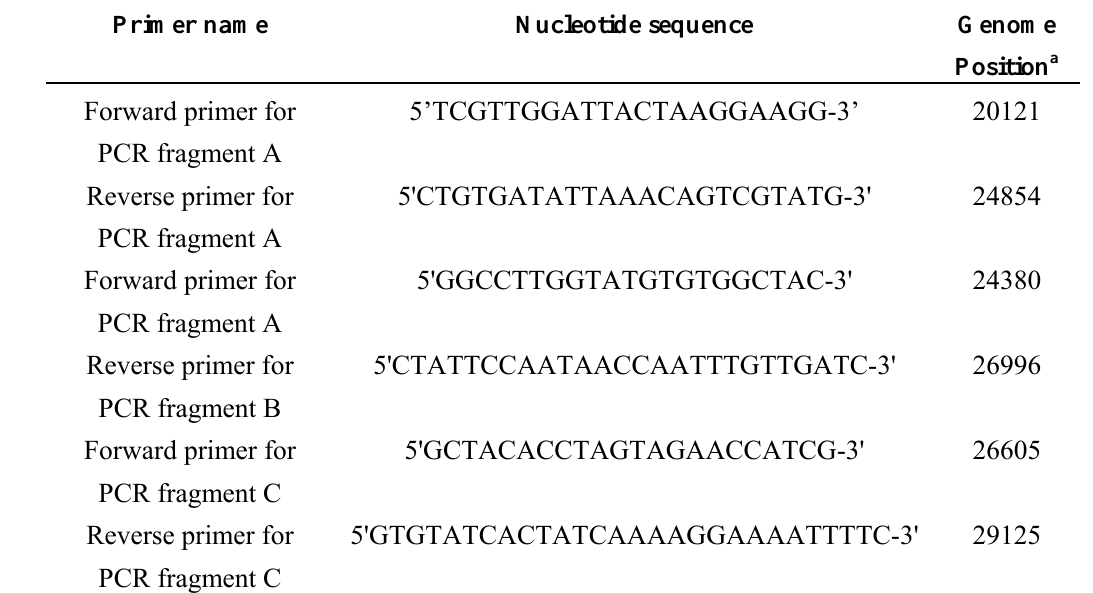
Table 5. Primer sequences used for the amplification of accessory and structural genes of feline coronavirus